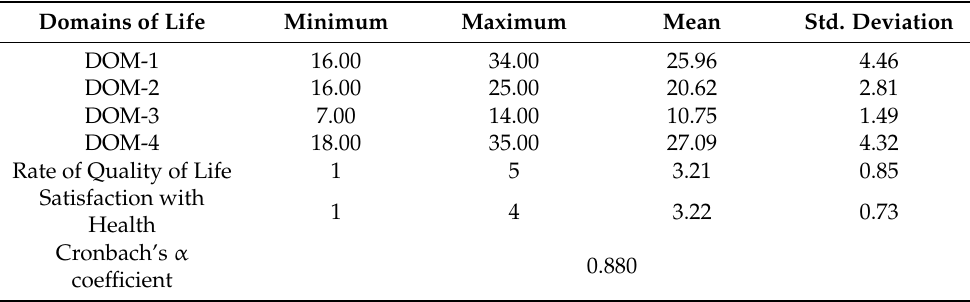
Table 2. Reliability of WHOQOL-BREF domain scores and two stand-alone questions.